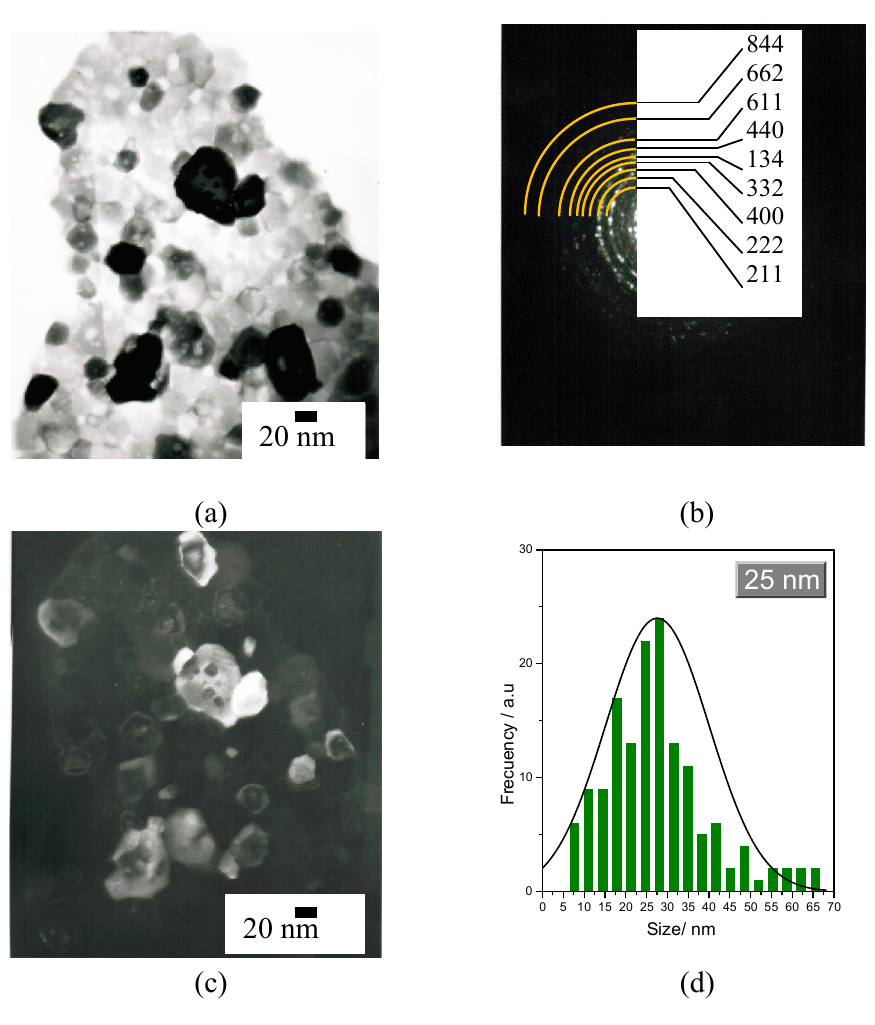
Figure 5. ( a ) TEM bright field micrograph of Lu powders annealed at 900 °C; ( b ) XRD diffraction pattern; ( c ) TEM dark field at (222) plane; ( d ) crystal size